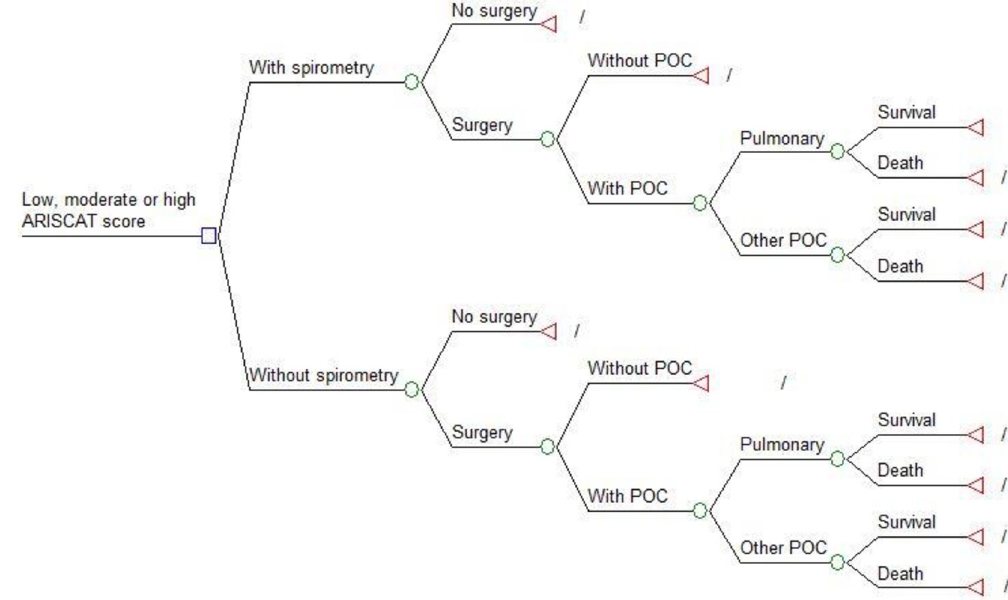
Fig 1. Decision tree for each ARISCAT risk level with two comparison groups: ARISCAT with and without spirometry. HGM costs ($US). � POC, postoperative